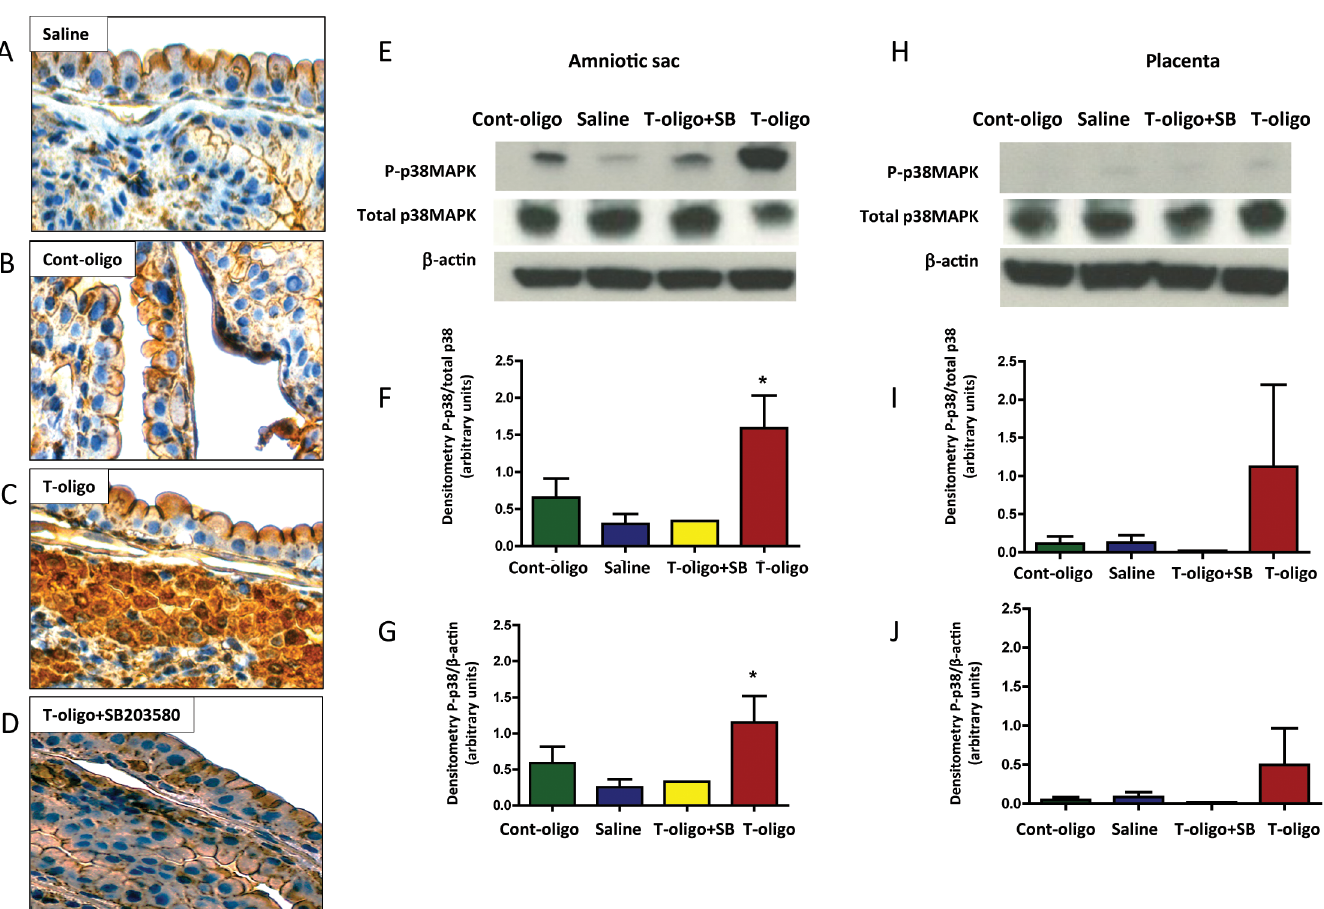
Fig 4. Animal models of T-oligo induced senescence. (A-D) Representative image of 3-nitrotyrosine (3-NT) modified proteins, an oxidative stress marker, in murine fetal membranes. Intrauterine injection of pregnant CD-1 mice were performed with either: A. Saline, B. Cont-oligo, C. T-oligo and D. T-oligo +SB23580 (p38MAPK inhibitor). ( E-G) Representative image of Western blot analysis and densitometric quantitation of p38MAPK activation in murine amniotic sac. E. Top panel = phosphorylated (P)-p38MAPK, middle panel = total p38MAPK and bottom panel = β -actin in Cont-oligo, saline, T-oligo +SB203580 (p38MAPK inhibitor) and T-oligo treated mice, respectively. F. Densitometric quantitation P-p38MAPK normalized to total p38MAPK in amniotic sac tissue or G. normalized to β -actin. T-oligo treatment produced a significant ( * ) increase in P-p38MAPK compared to saline and Cont-oligo treated groups. The co-treatment of T-oligo and SB203580 showed similar results to controls (saline and Cont-oligo). ( * ANOVA, p < 0.05). Results are representative from 3 animals/ group. (Telomere mimetic overhang sequence (T-oligo, [TTAGGG] 2 ); control oligonucleotides (Cont-oligo, [AATCCC] 2